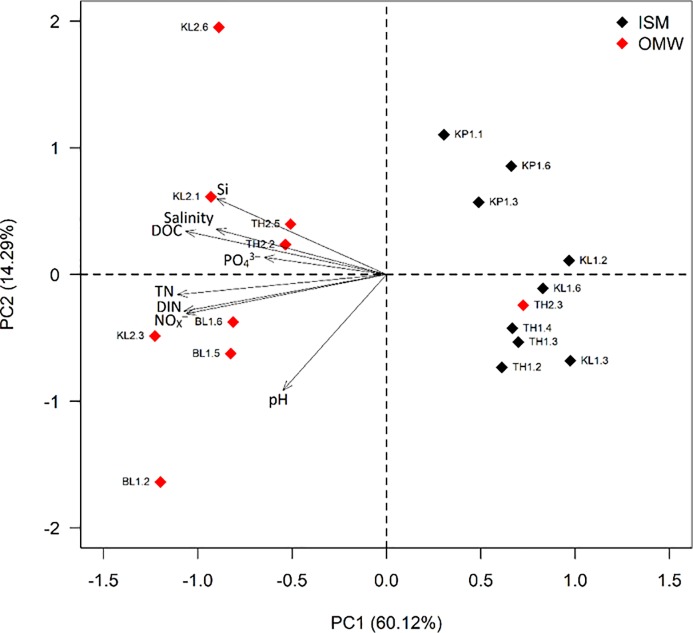
Principal component analysis (PCA) to ordinate the eighteen collected water samples collected samples from ISM and OMW based on their environmental parameters.The arrows show the direction of the environmental parameters. DIN, dissolved inorganic nitrogen; TN, total nitrogen; DOC, dissolved organic carbon.